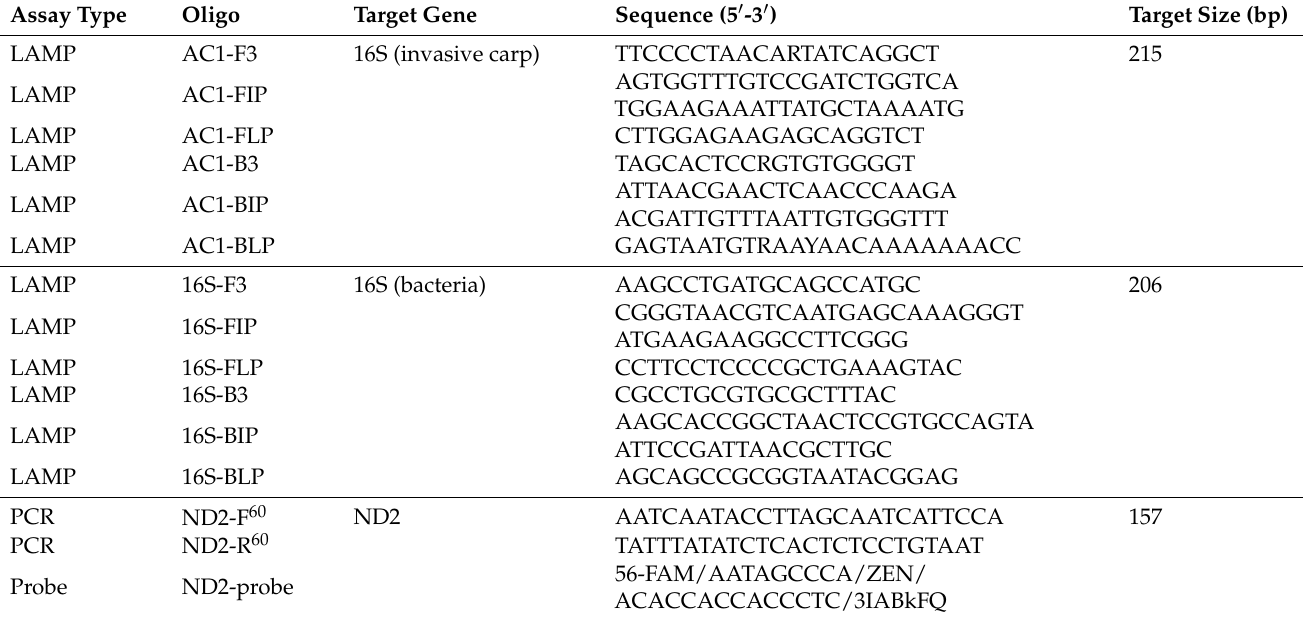
Table 1. Oligonucleotides used for the invasive carp LAMP assay and for qPCR.